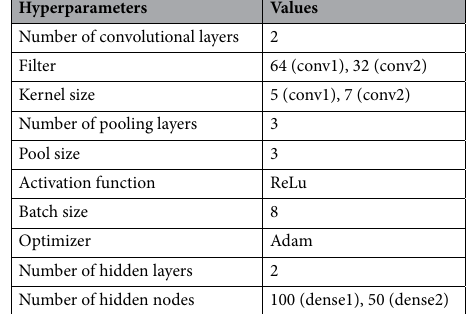
Table 9. Hyperparameter tuning of CNN model with padding data for